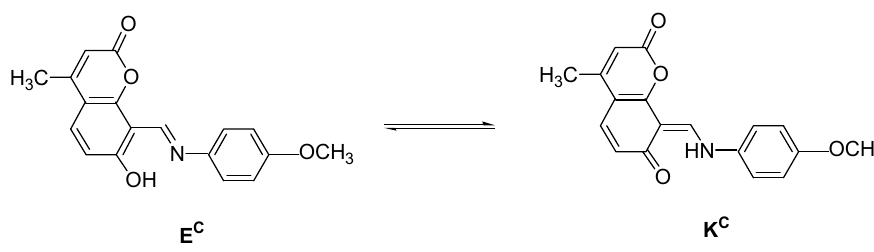
Scheme 5. Tautomeric forms of the model compound 3